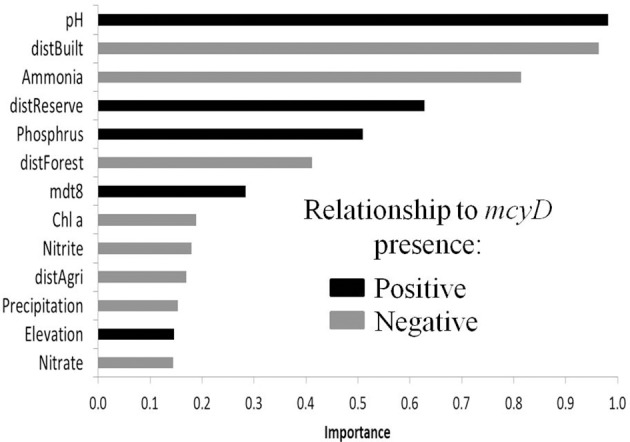
The relative importance of different local and regional parameters using GLM. The results of the same analysis performed with cross correlated in a distribution model of mcyD genes produced parameters removed and for locations found in the north of Israel are shown in Supplementary Table 3, and the coefficients relating each parameter to the presence/absence of mcyD are shown in Supplementary Table 4.